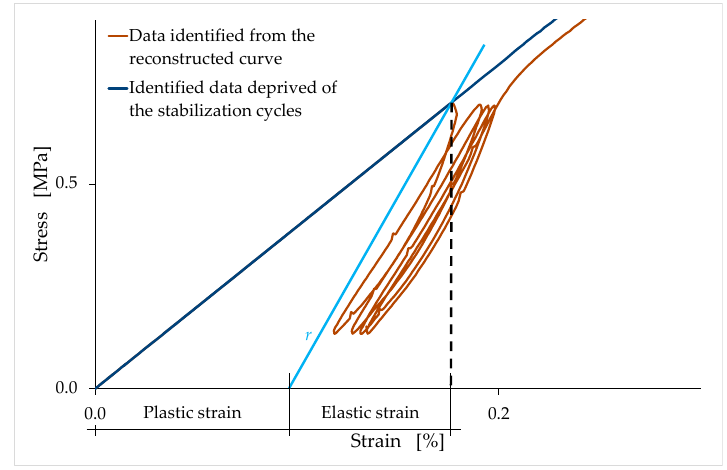
Figure 22. The two components of the strain at the stabilization stress value: the elastic strain is the strain recovered at the end of an ideal straight path of unloading, carried out for the strain value under consideration (the straight line, r , is parallel to the straight line r 4 in Figure 21); the plastic strain is the permanent strain after unloading.